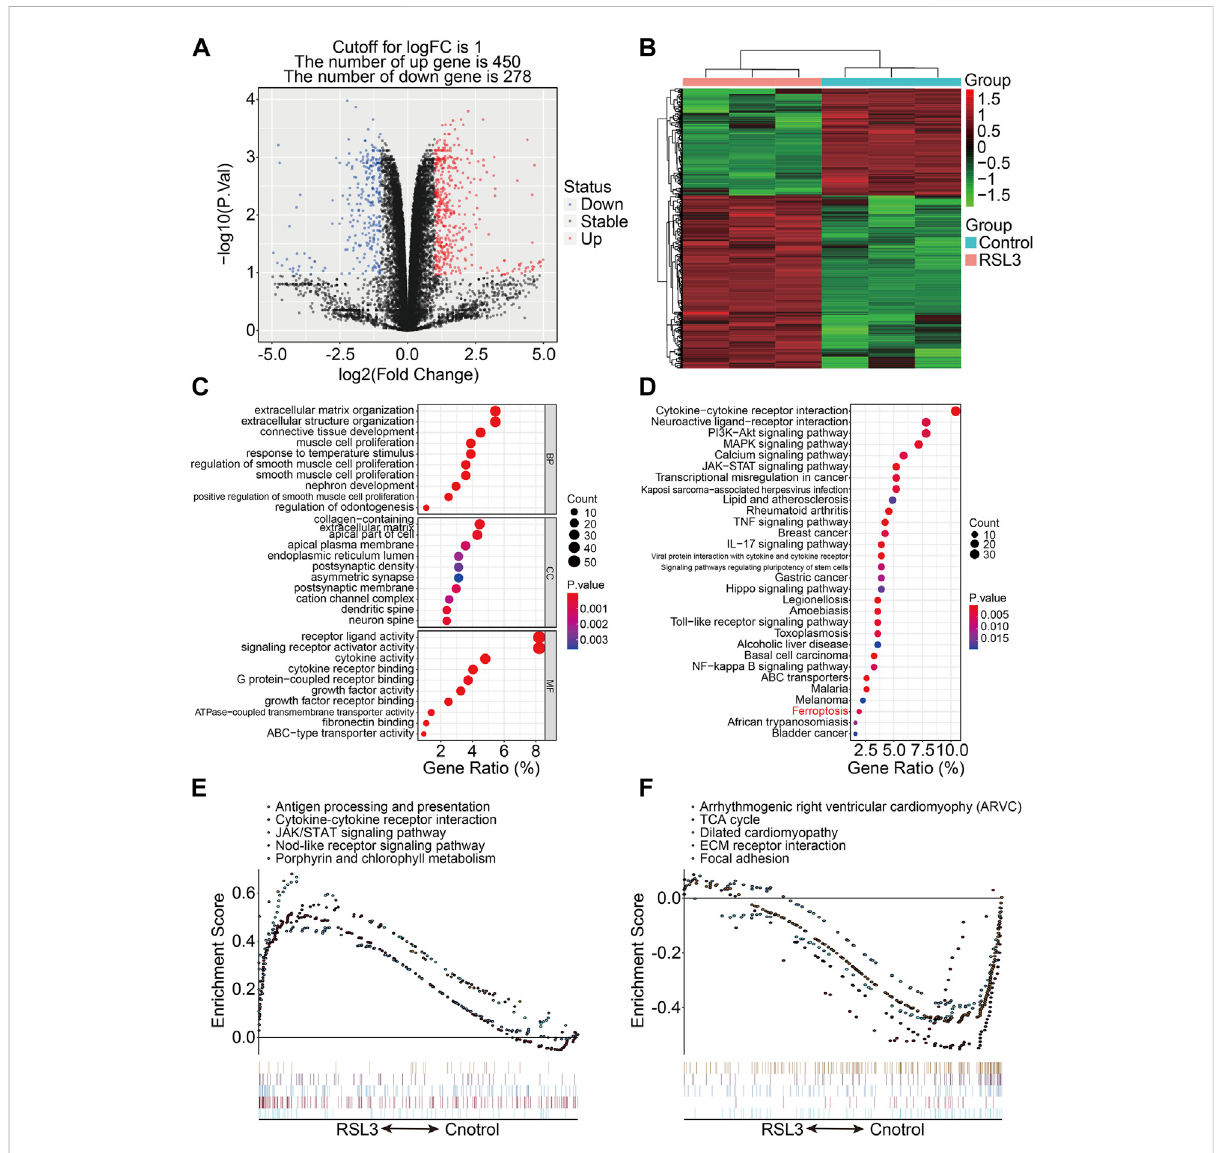
FIGURE 1 Transcriptional changes induced by RSL3 and functional analyses. (A) Volcano plot represents genes differentially expressed between RLS3- treated cells and control cells. (B) Heatmap for the expression pro fi le of ferroptosis-associated genes (FAGs). (C,D) GO and KEGG analyses of FAGs. (E,F) Gene set enrichment